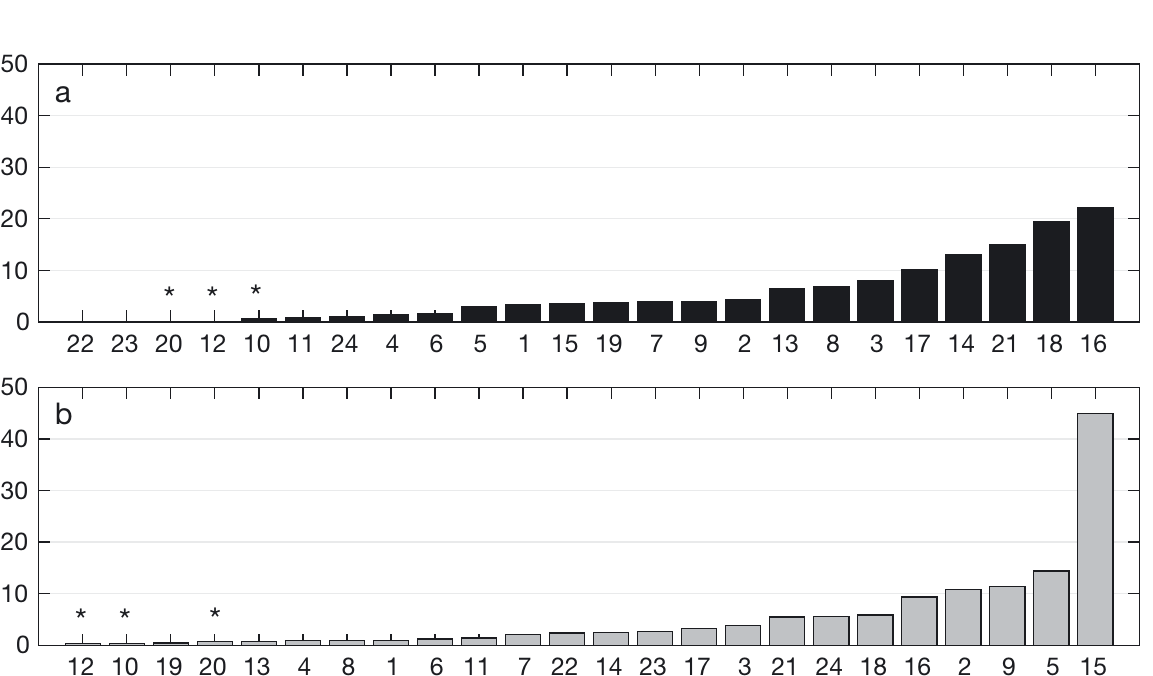
Fig. 8. Percentage of salmon lice which farms (a) emit and (b) receive to and from other farms accounting for mortality and excluding self-infection. * : the 3 highly isolated farms. Percentage is normalized with total amount of particles released from 1